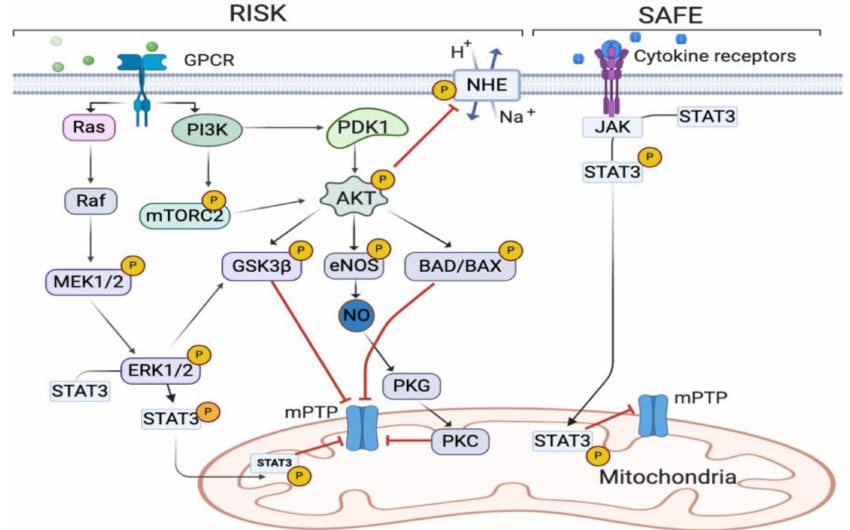
Figure 2. Simplified overview of major protective signaling pathways involved in RIPC, the reperfu- sion injury salvage (RISK) pathway, and the survivor activating factor enhancement (SAFE) pathway. Abbreviations: G protein-coupled receptors (GPCRs); MEK1/2, also known as mitogen-activated protein kinase 1/2; Erk1/2, extracellular-regulated kinases 1/2; PI3K, phosphatidylinositol-4, 5- bisphosphate3-kinase; Bcl-2-associated death promoter (BAD); Bcl-2-associated X protein (BAX); glycogen synthase kinase-3ß (GSK3ß); mitochondrial permeability transition pore (mPTP). Akt, also known as protein kinase B; nitric oxide synthase 3/endothelial nitric oxide synthase (NOS3/eNOS) and nitric oxide (NO); Janus kinase (JAK), protein kinase G (PKG); protein kinase C (PKC), mechanis- tic target of rapamycin (mTOR); sodium hydrogen exchanger (NHE); signal transducer and activator of transcription 3, STAT-3. P indicates phosphorylation. Red lines indicate